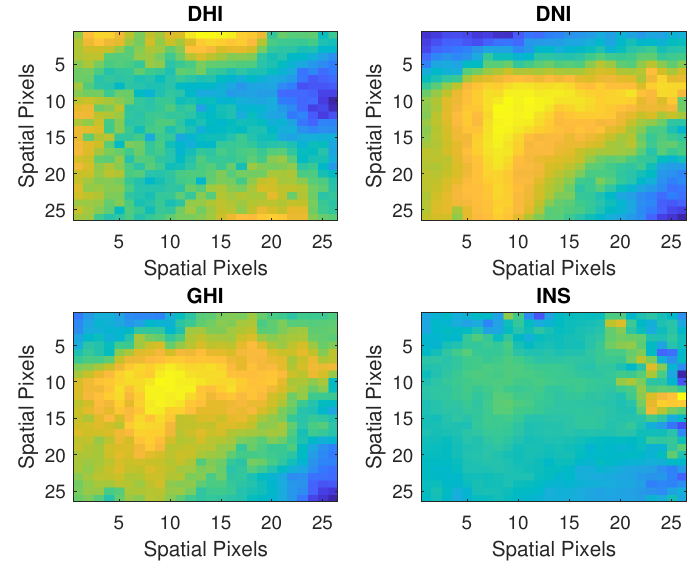
Figure 3. The satellite irradiance components DHI, DNI, GHI, and insolation